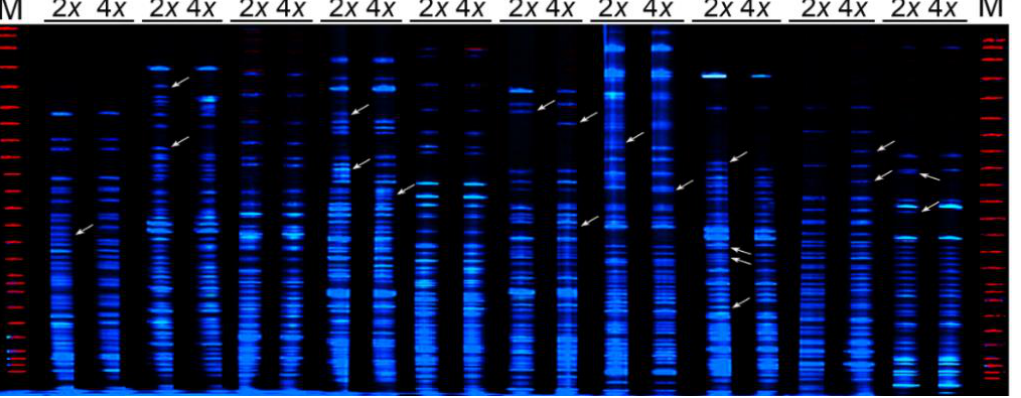
Figure 2. DNA-AFLP profiling of diploid and autotetraploid line 1 (T1) of C. nankingense . The arrows indicate genome changes.